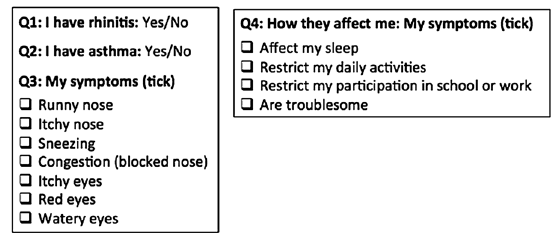
Table 2 Questions on symptoms and impact of symptoms (from Bousquet et al.